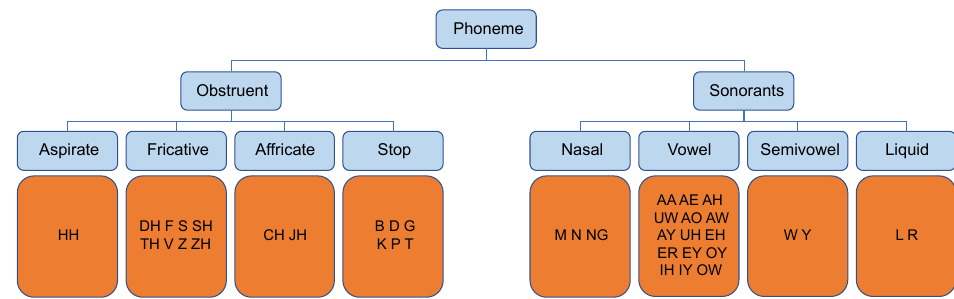
Figure 7. The hierarchy of phonemes in English